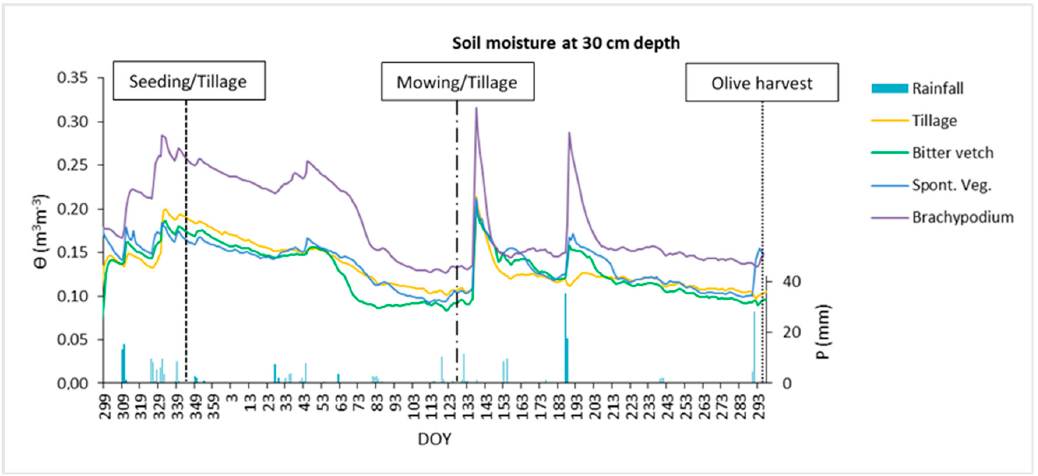
Figure 8. Daily water volumetric content at 30 cm depth during the crop season 2016 / 2017 for the four treatments and rainfall depth. DOY: day of the year.